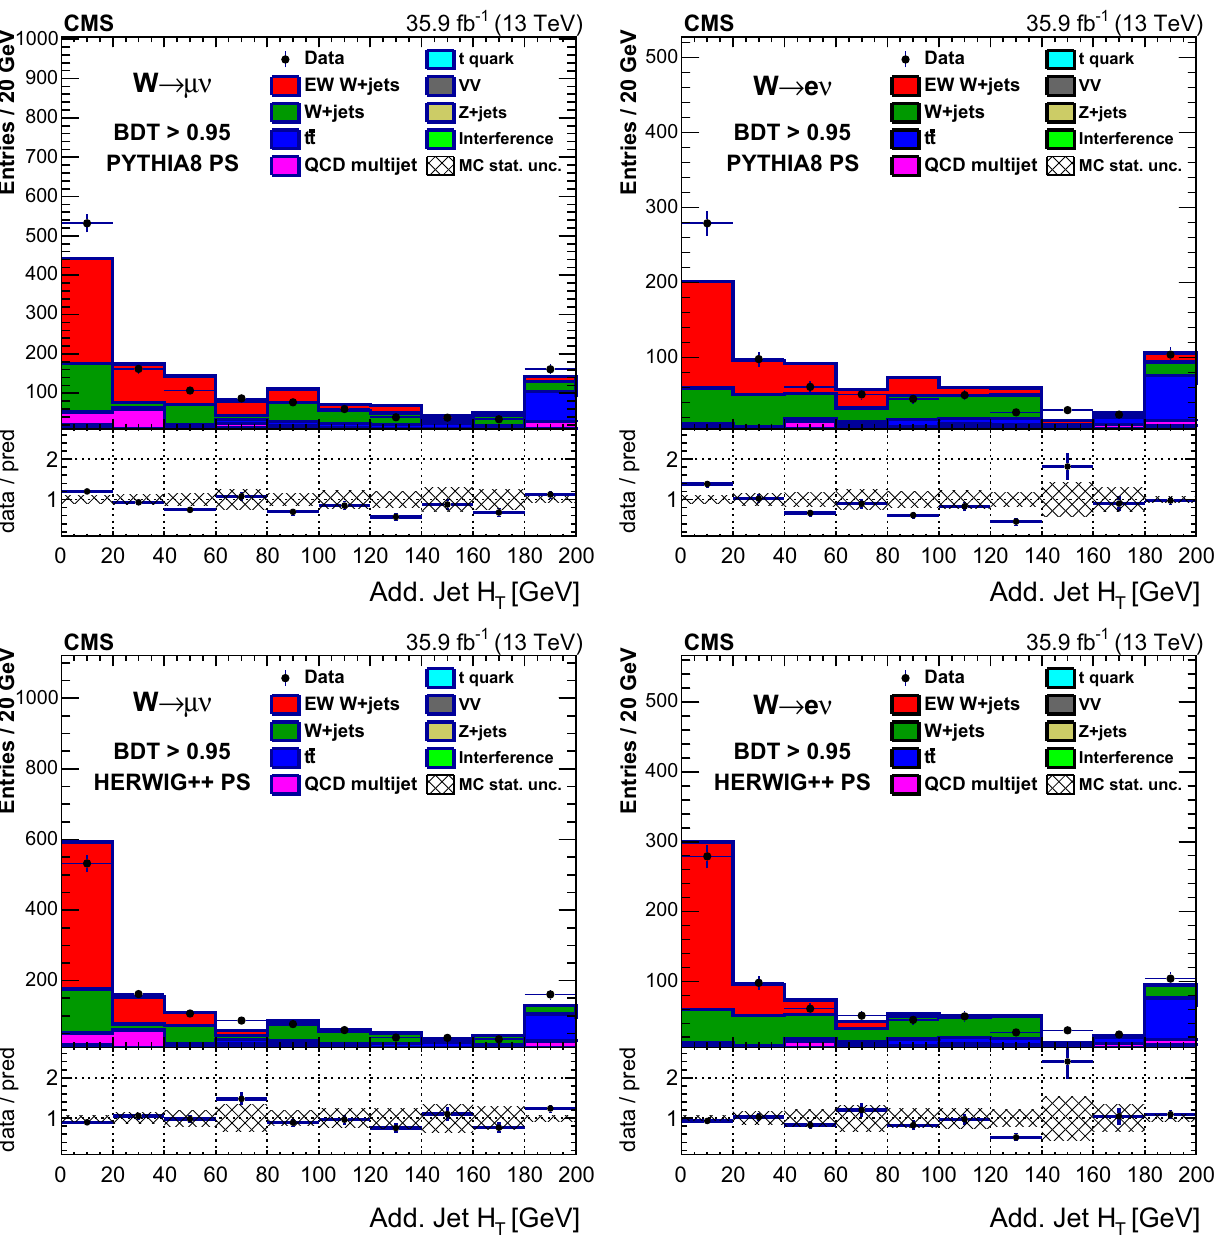
Fig. 16 Total H T of the additional jets for BDT > 0 . 95 in the muon (left) and electron (right) channels including the signal prediction from MadGraph 5_a mc@nlo interfaced with pythia parton show-